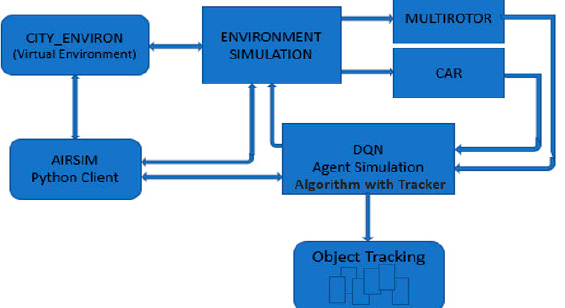
Figure 2. The design depicts a linked virtual world using the AirSim simulation platform to execute network algorithms and evaluate a tracking technique in real-time